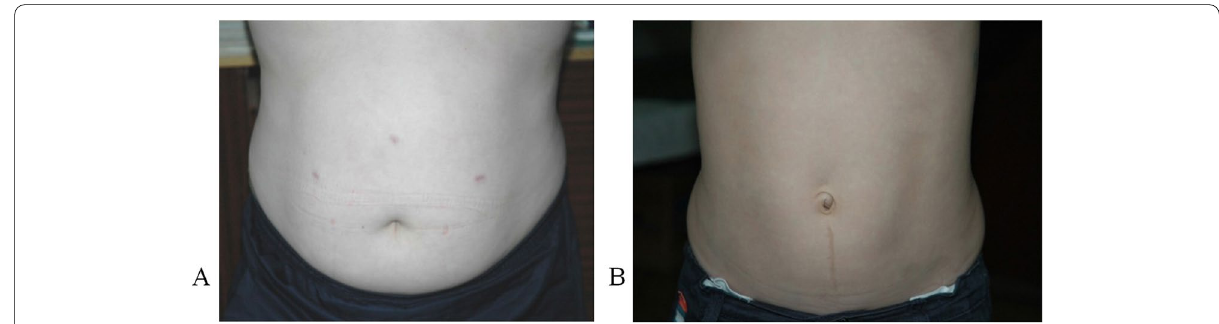
Fig 4 A , B : A Postoperative scars in a 12-year-old boy, 1 month after laparoscopic excision of the urachal remnant. B Postoperative scar in a 13-year-old boy, 3 years after the conventional operation